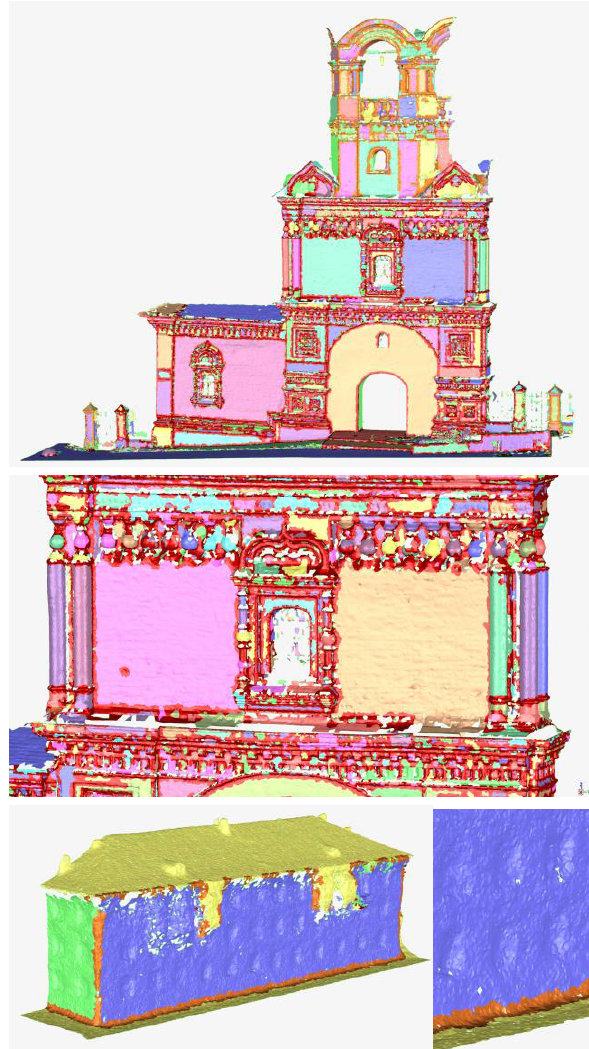
Figure 9 . Features recognition for opening and decorative details on TLS spatial dataset applied on Heritage built object main front (above), and opening and decorative apparatus (middle). Failed features recognition of openings on urban fronts in UAV grid plan dataset